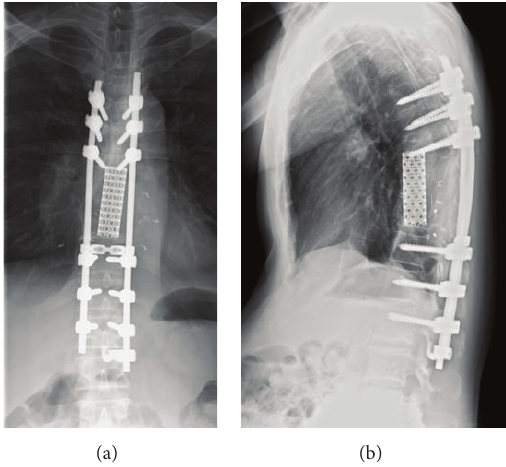
Figure 4: Postoperative radiographs. (a) Anteroposterior, (b)